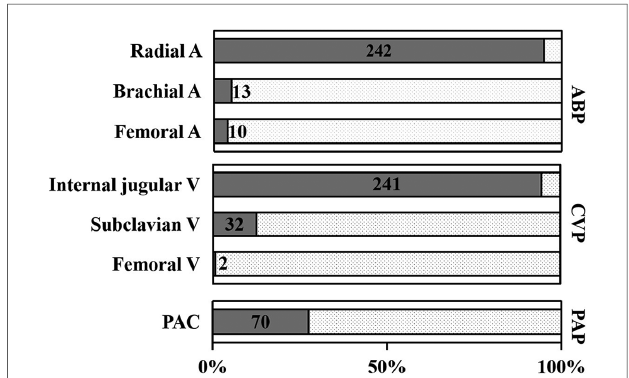
FIGURE 1 Hemodynamic monitoring. Radial A was the most conventional arterial blood pressure monitoring site during the operation (242/255, 94.9%). Femoral A puncture (10/255, 5.1%) was applied in the postoperative placement of the intra-aortic balloon pump (IABP) or alternative site while dif fi cult catheterization of Radial A or Brachial A occurred. Internal V (241/255, 94.5%) was the most conventional punctual site in central venous puncture, and PAC (70/255, 27.5%) was utilized in less than one third of OPCAB patients. ABP, arterial blood pressure; CVP, central venous pressure; A, artery; V, vein; PAP, pulmonary arterial pressure; OPCAB, off-pump coronary artery bypass; PAC, pulmonary arterial catheter.